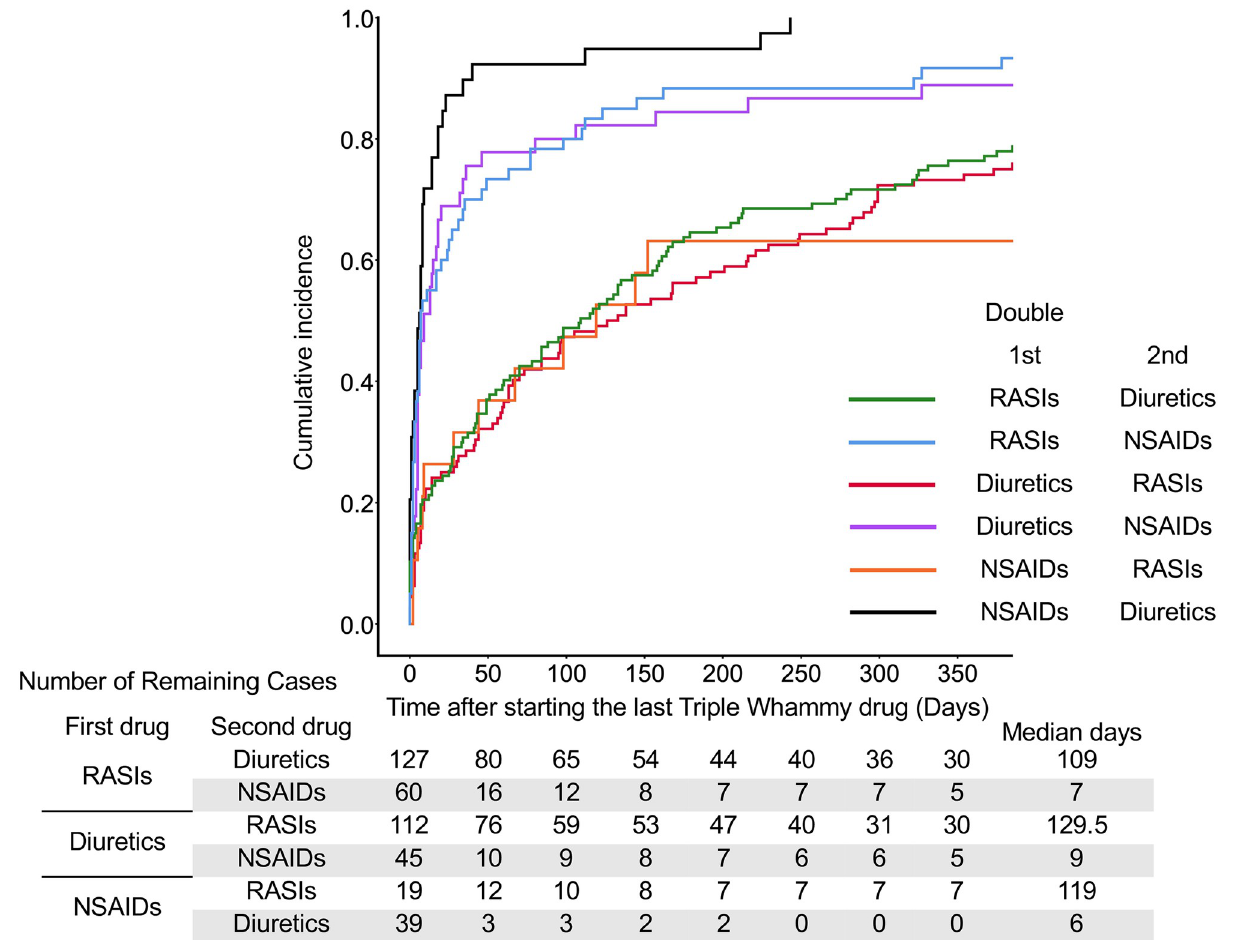
Fig 4. The cumulative incidence with TW drugs used in double drug groups. Cases in which multiple TW drugs were started at the same time were excluded. Median days indicate the date when the cumulative failure rate reached 50%.